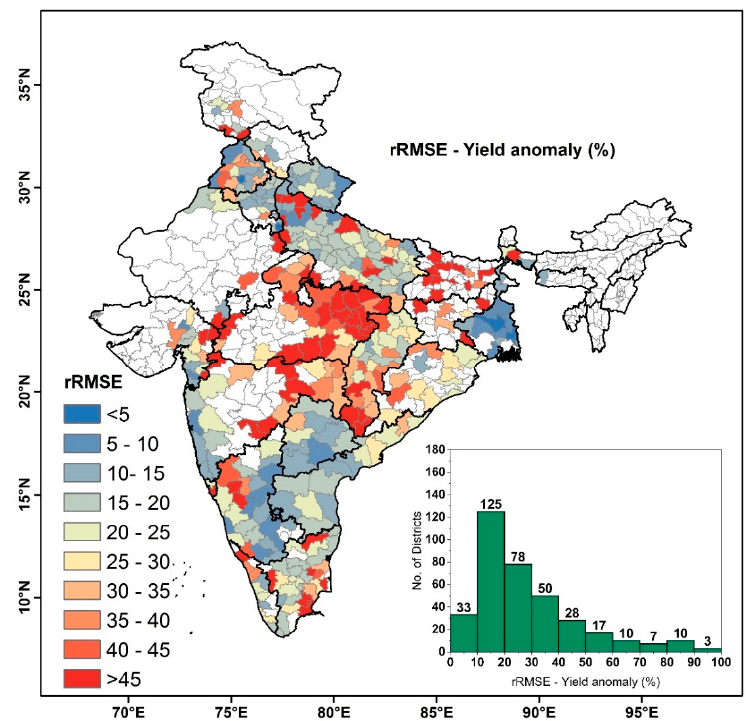
Figure 5. District-wise relative Root Mean Square Error (rRMSE) as a map and as a histogram. The histogram shows rRMSE values on the X-axis and the number of districts on the Y-axis.